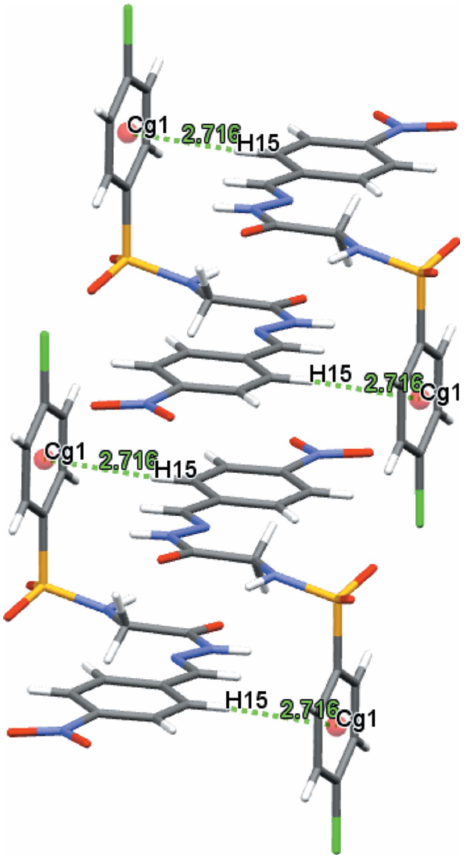
Figure 4 The C—H (cid:2)(cid:2)(cid:2) (cid:2) interactions (green dotted lines) observed in the structure of the title compound.